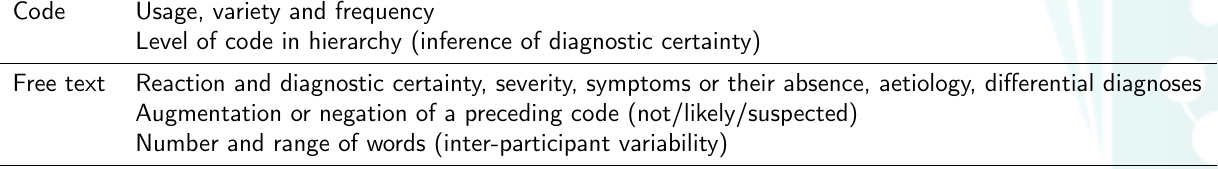
Table 2: Analysable elements from